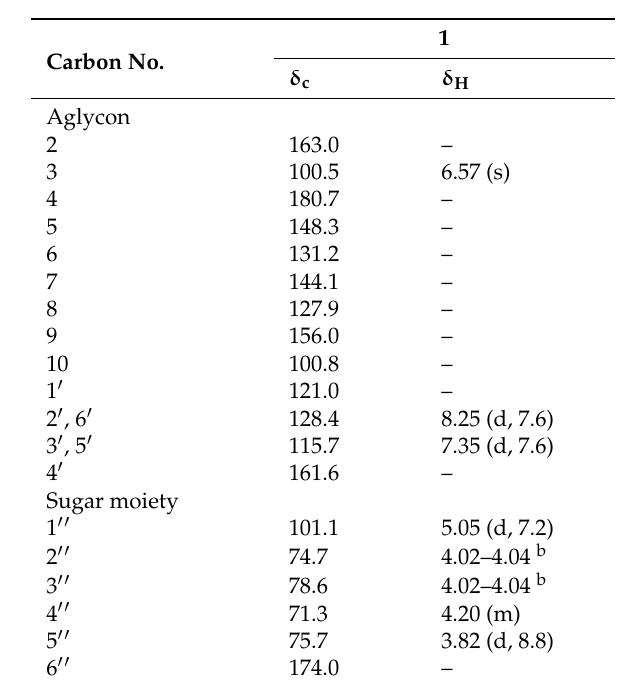
Table 2. 1 H (400 MHz) and 13 C (100 MHz) NMR data for compound 1 (pyridine- d 5 and D 2 O (5:5), δ ppm, coupling patterns, J in Hz) a (see Supplementary